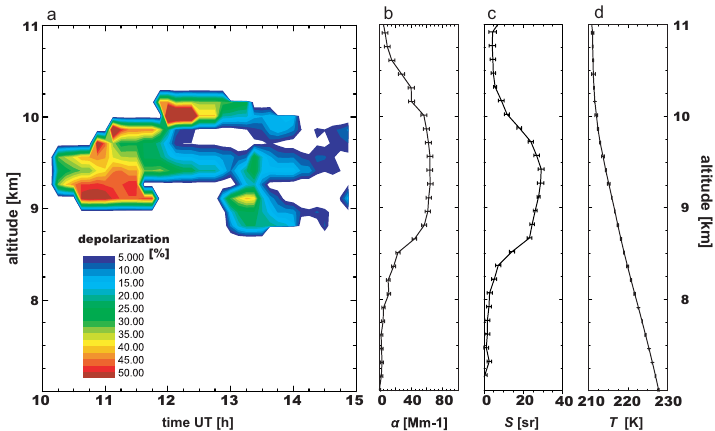
Fig. 6. (a) Development of a cirrus cloud above Esrange between 14:31 and 17:45UT on 25 January 2012 in terms of the particle depolar- ization ratio and profiles of the extinction coefficient α (b) , the lidar ratio S (c) , and temperature T (d)